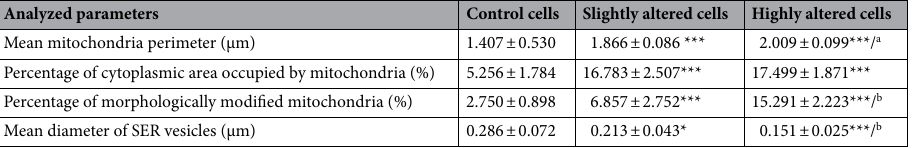
Table 1. Morphometric analysis of selected parameters of Leydig cells from control and flutamide-treated animals. Data are expressed as means ± SD (n = 6 animals/each group). * P < 0.05 versus control cells; *** P < 0.001 versus control cells; a P < 0.05 versus slightly altered cells; b P < 0.01 versus slightly altered